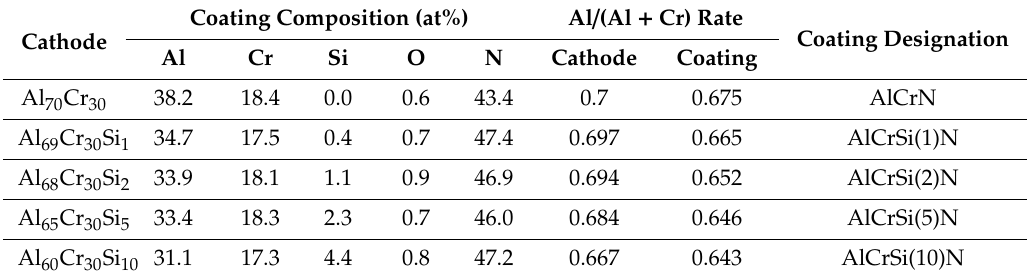
Table 1. The chemical composition of the coatings deposited from di ff erent